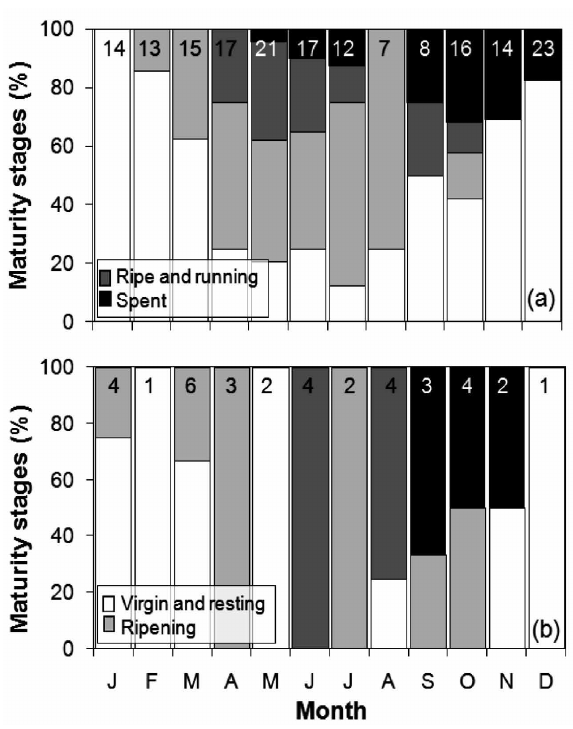
Fig . 2. – Monthly percentage of values of sexual stage for a) females and b) males of Mycteroperca fusca caught between January 2004 and December 2005 in waters of the Canary Islands. All calculated values of the index were grouped to show monthly variations over a single year. Number of fish sampled is shown for each